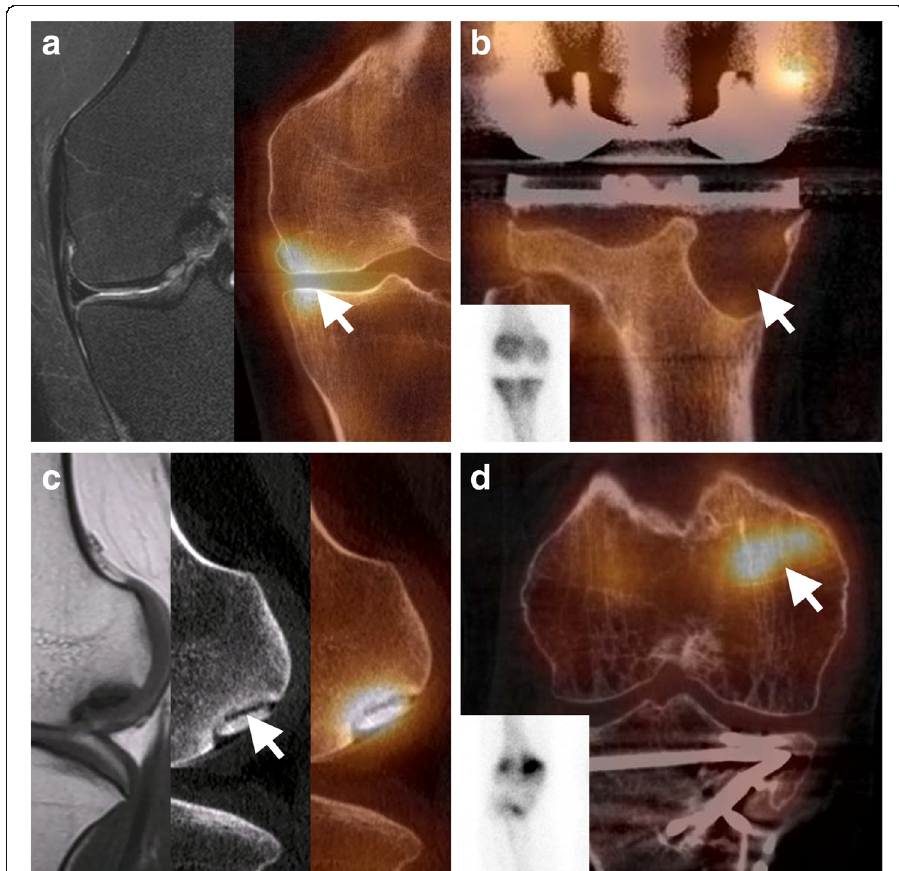
Fig. 4 Bone SPECT/CT imaging of the painful knee. Illustration of bone SPECT/CT applications in imaging the painful knee. a medial compartment overloading demonstrated on bone SPECT/CT but not visible on MR STIR imaging, b loosening of arthroplasty due to large granulomas causing only diffuse non-specific uptake on planar imaging (inset), c example of osteochondritis dissecans with a gap surrounding the fragment not visible on MRI, d complex osteosynthesis of the proximal tibia after trauma with pain recurrence due to stress fracture of the distal femur on planar (inset) and SPECT/CT, but unsuspected on anatomical